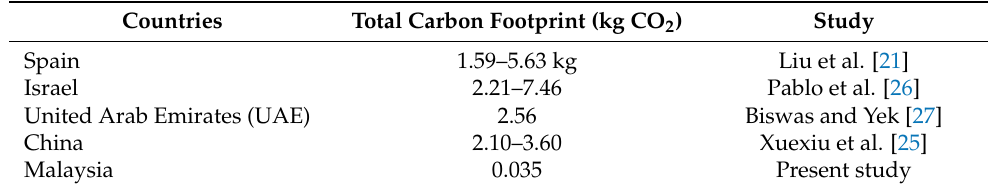
Figure 3. Contribution of relative carbon footprint, according to phase of process, by SWRO in the operation stage.